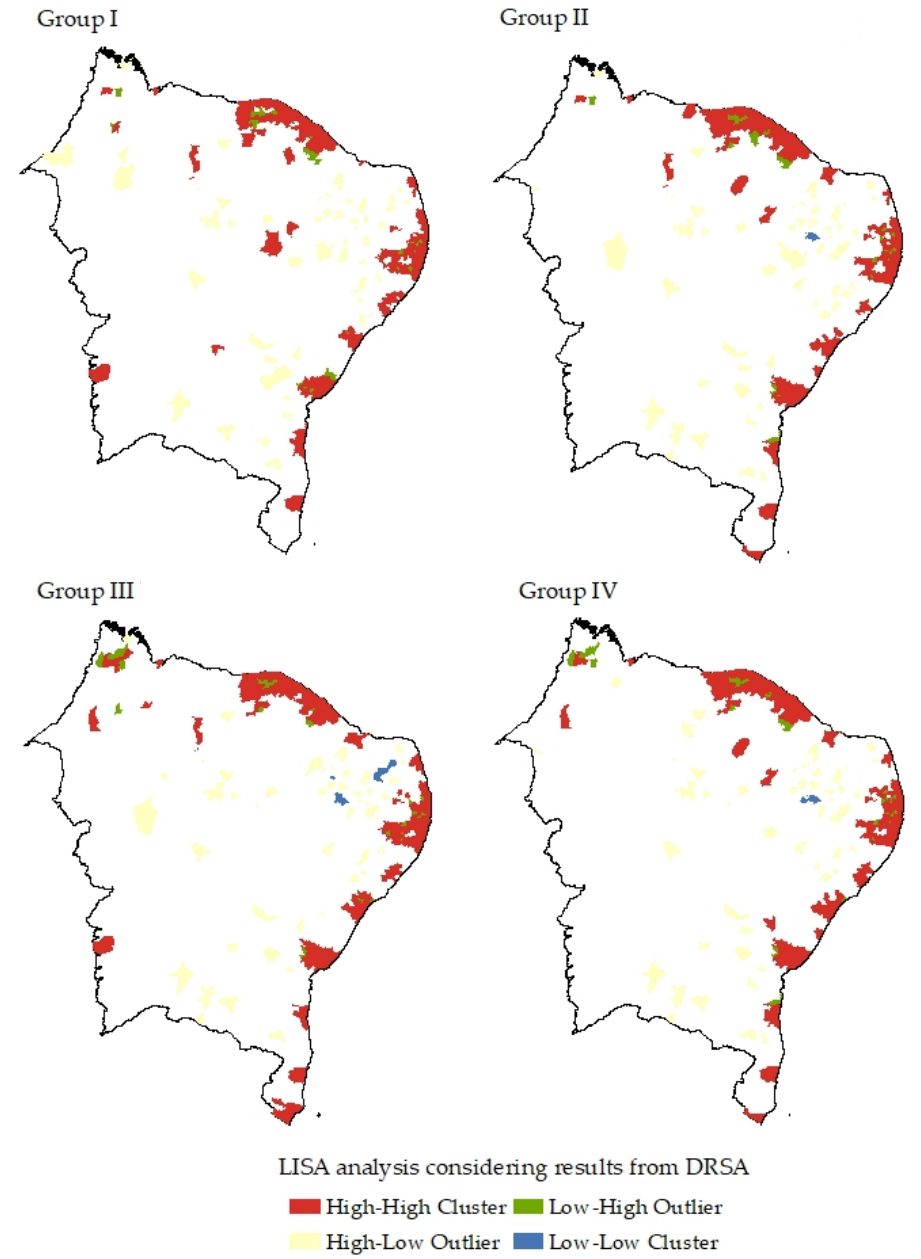
Figure 4. LISA analysis after DRSA results. Each group describes the clusters obtained from the Moran index applied to the year of 2020.